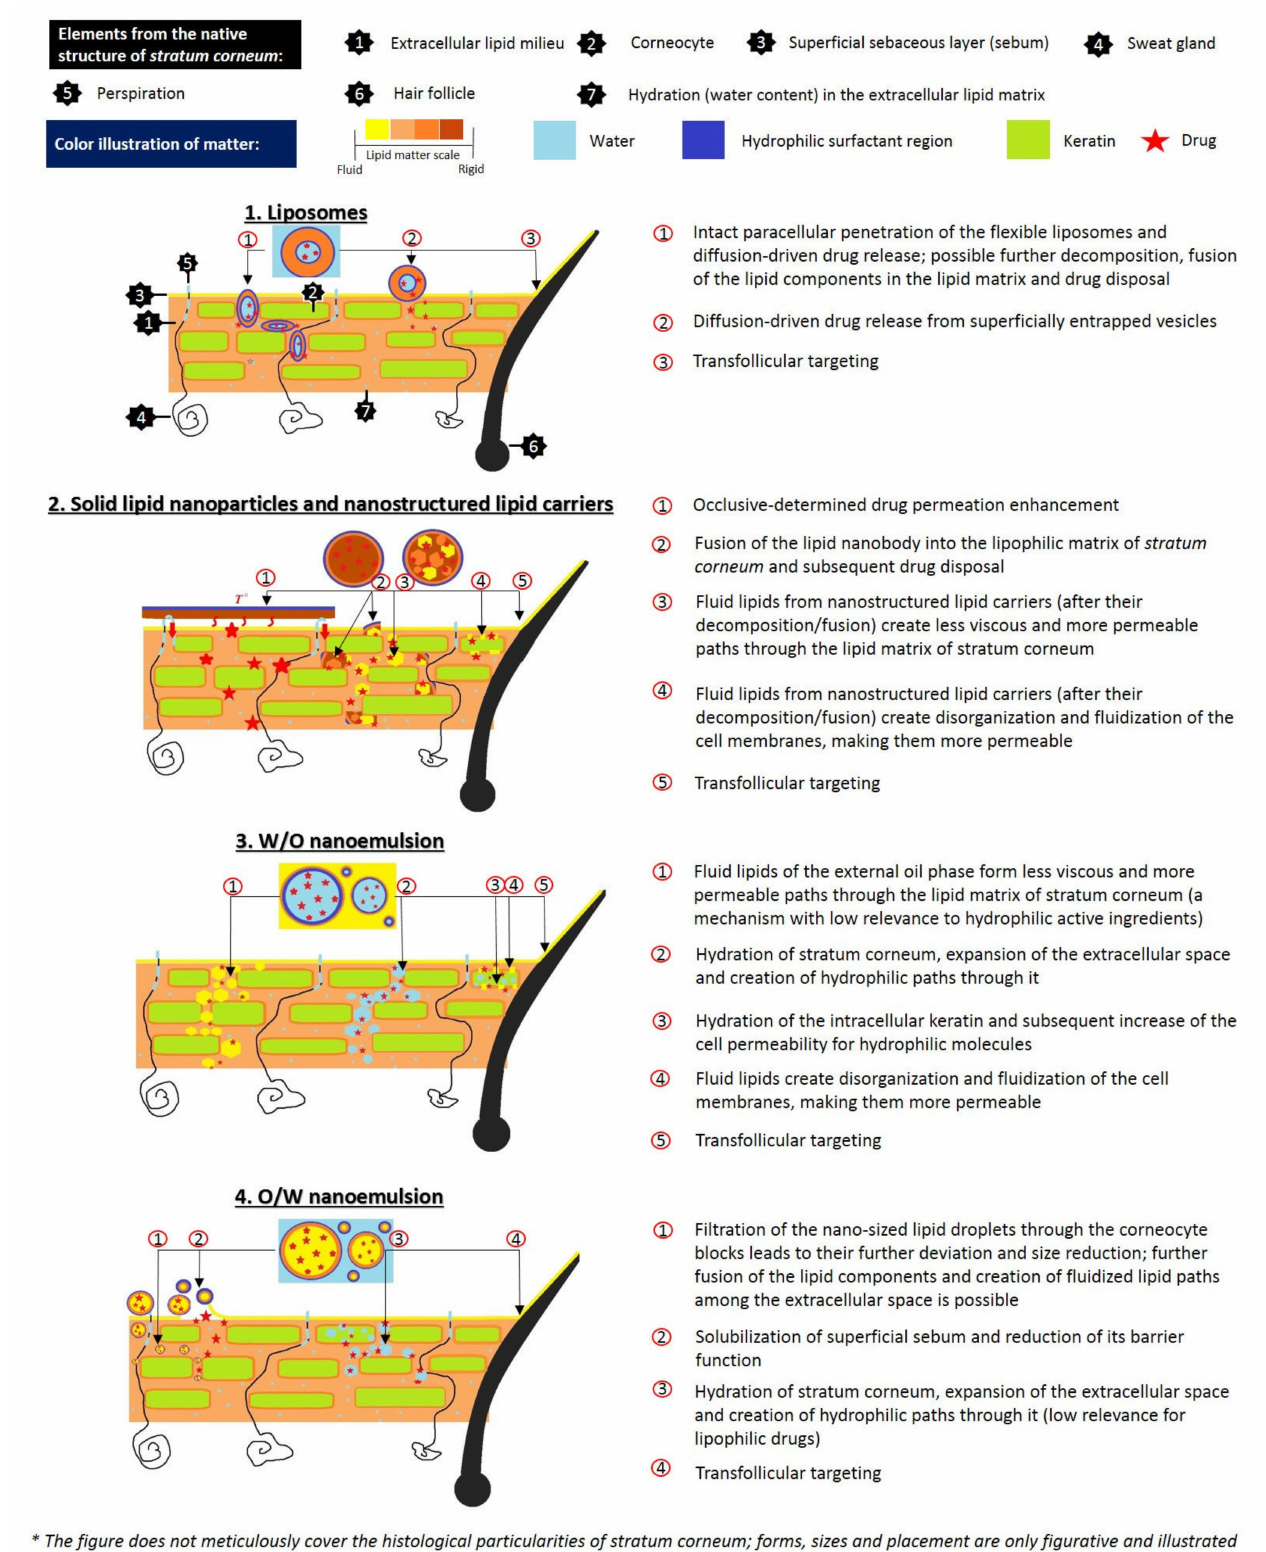
Figure 1. Possible mechanisms of drug permeation enhancement through stratum corneum by lipid-based nanoparti-